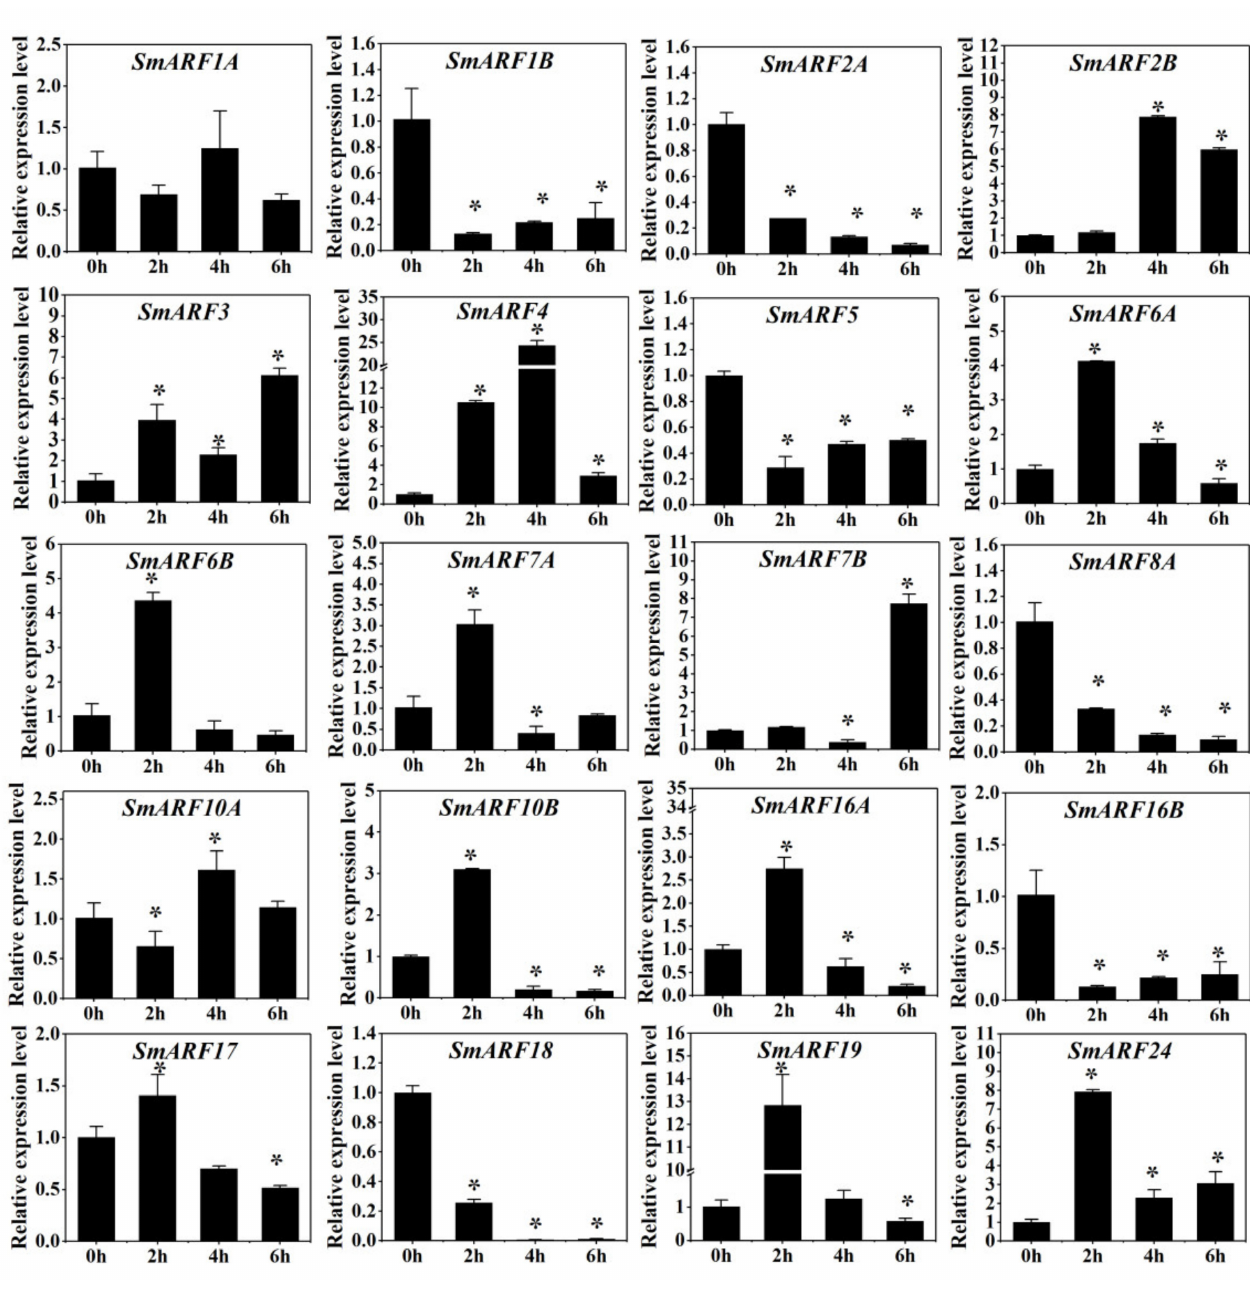
Figure 7. Expression analysis of SmARFs after 2,4–D treatment. The relative mRNA levels of the group at 0 h were used for the reference. The relative expression was calculated using the of 2 −(cid:52)(cid:52) Ct method. Values are means ± SD ( n = 3). * represents significance at p < 0.05 compared with the